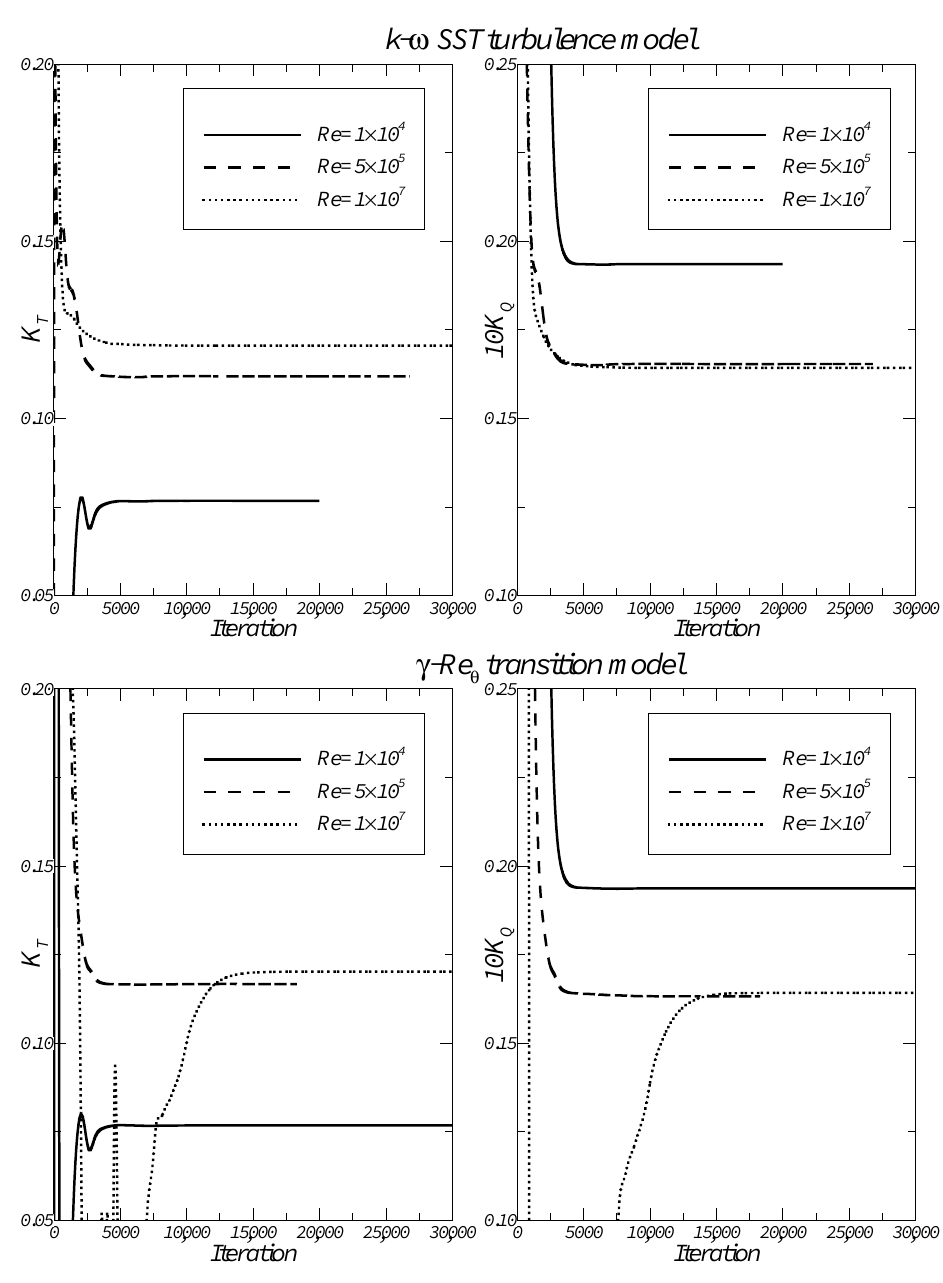
Figure 4. Iterative convergence of K T ( left ) and 10 K Q ( right ) at J = 0.568 using the k − ω SST turbulence model ( top ) and γ − ˜Re θ transition model ( bottom t